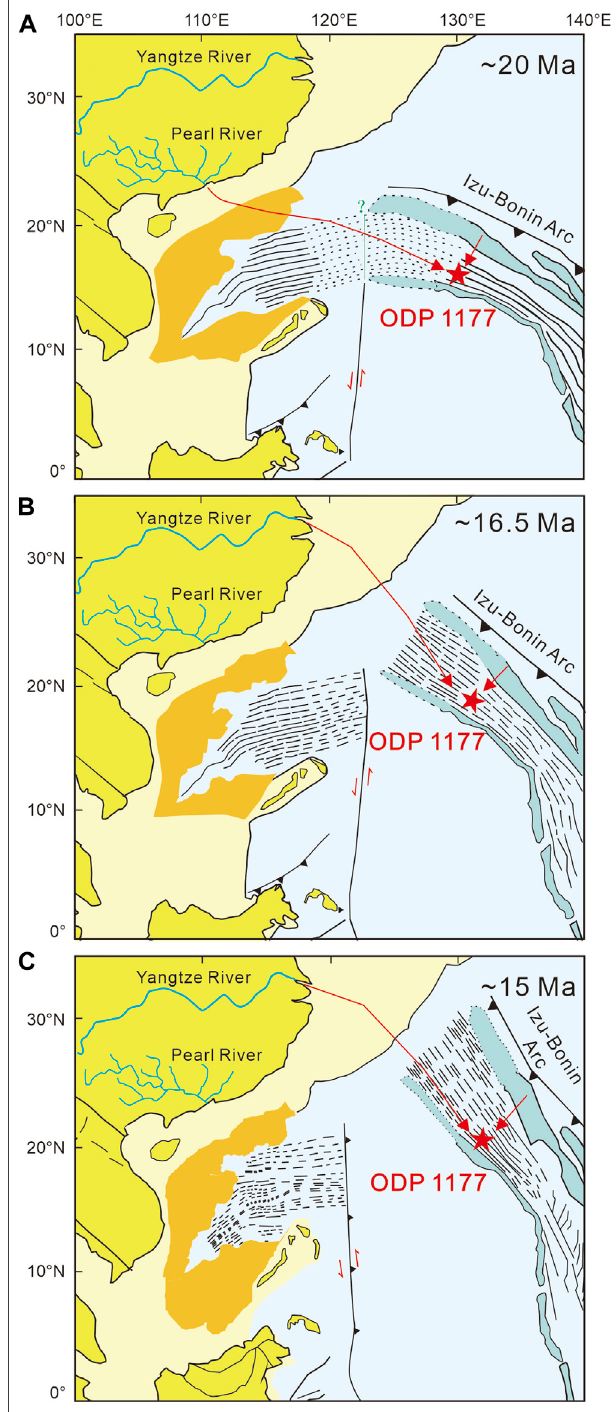
FIGURE5| Thetectonicand provenanceevolutionoftheShikokuBasin at ~20 Ma (Liu et al., 2021), ~16.5 Ma (this study), and ~15 Ma (Liu et al., 2021). (A) The Shikoku Basin connected with the South China Sea, and Site 1177 received materials from the Pearl River and Izu-Bonin Arc at ~20 Ma. (B) The initial complete separation between the Shikoku Basin and the South China Sea was at ~16.5 Ma, and Site 1177 began to receive materials from the Yangtze River and Izu-Bonin Arc. (C) The Shikoku Basin ( Continued